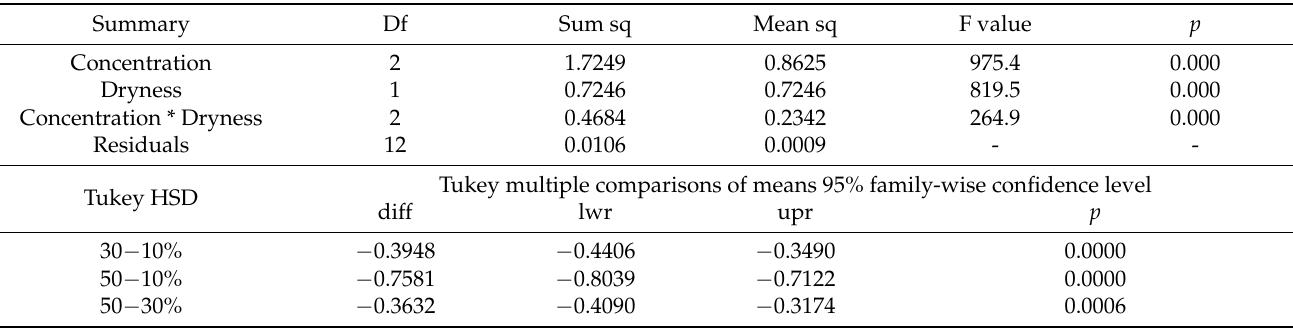
Table 11. Summary of factor importance and Tukey HSD results (KTD).